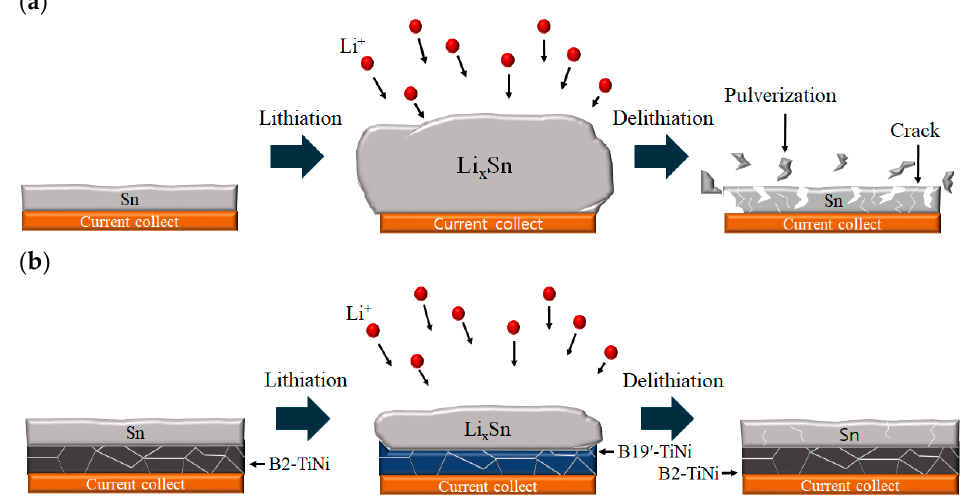
Figure 1. Schematic of the volume-change mechanism in ( a ) Sn anodes; ( b ) Sn-TiNi thin-film anodes during charge/discharge cycling.